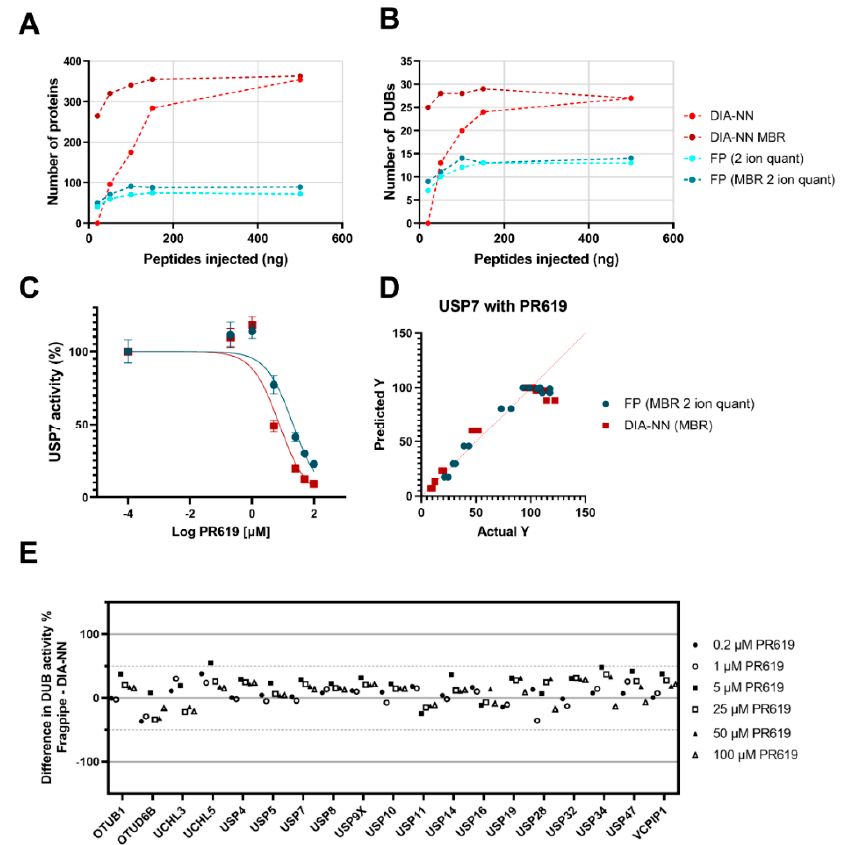
Figure 3. ( A – D ) Concentration-dependent quantification precision and sensitivity with DDA and DIA. Increasing quantities of peptides injected into the timsTOF from an IP with 100 µg of lysate protein starting material. ( A ) Number of quantified proteins for DIA-NN and Fragpipe 1 ion quant (+/ − MBR). ( B ) Number of quantified DUBs for DIA-NN and Fragpipe 2 ion quant (+/ − MBR). ( C ) USP7 IC 50 curve showing reduction of USP7 intensity with increasing PR619 concentrations, collected as either DIA data analysed with DIA-NN MBR* or DDA data Fragpipe data 2 ion quant MBR* fit to Y = 100/(1 + 10ˆ((X-LogIC 50 ))). * MBR as part of a larger dataset with other inhibitors. ( D ) Predicted vs. actual Y values of the IC 50 curve shown in ( C ). ( E ) Difference plot of common DUBs identified by both DIA-NN MBR and Fragpipe 2 ion quant MBR with DIA-NN percentage activity subtracted from Fragpipe percentage activity at various PR619 concentrations. MBR = match-between-runs, FP =